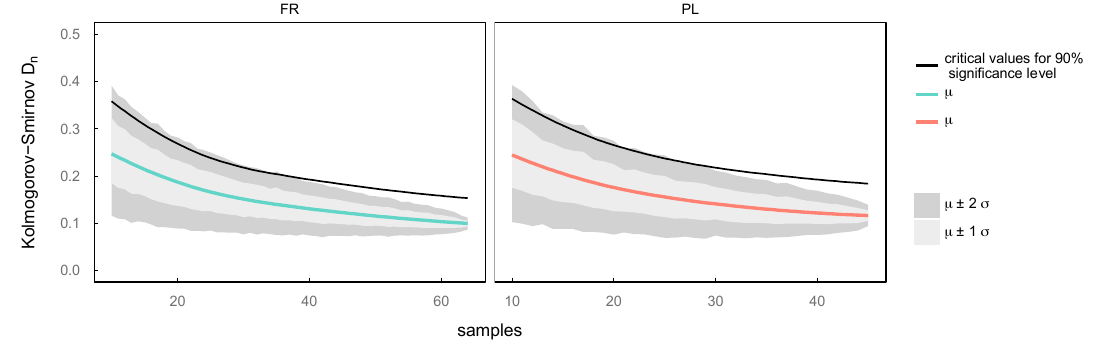
Figure 4. Mean and regions of one and two standard deviations of Kolmogorov-Smirnov’s statistic as function of sample size from Monte-Carlo-based sampling for sites Flat Roof (FR) and Parking Lot (PL). Critical values for 90% confidence are indicated as black solid line.